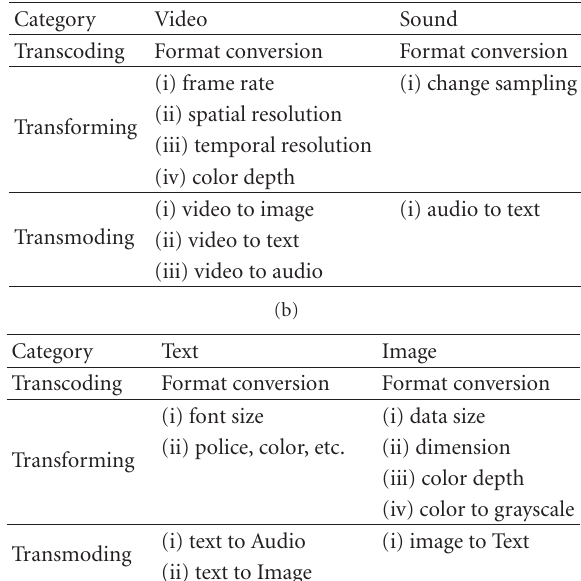
Table 1: Adaptations of